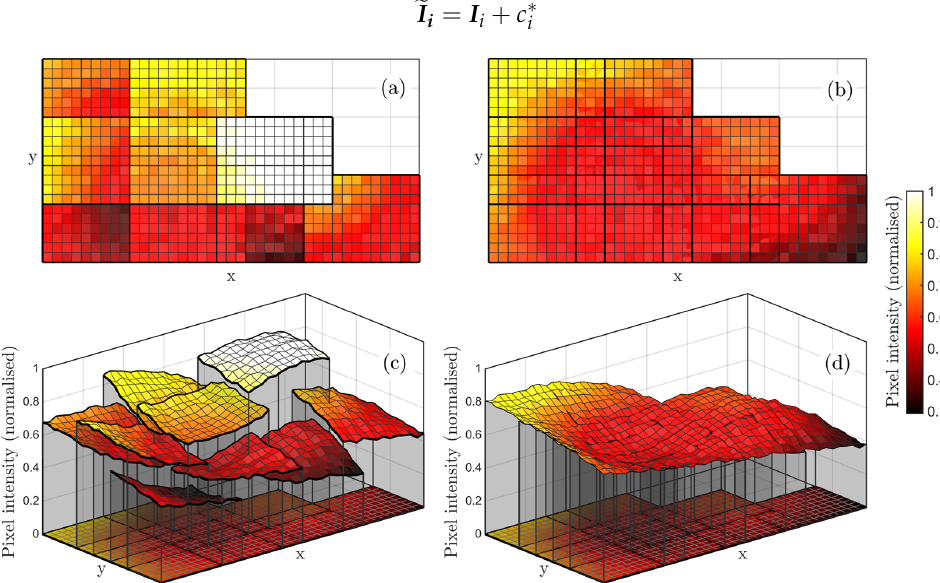
Figure 4. Exemplification of image blending, used in FiPAM. ( a ) Aligned images with discontinuous pixel intensities; ( b ) images after correction of discontinuities; ( c ) 3D plot of uncorrected pixel intensities; ( d ) 3D plot of the corrected image set.